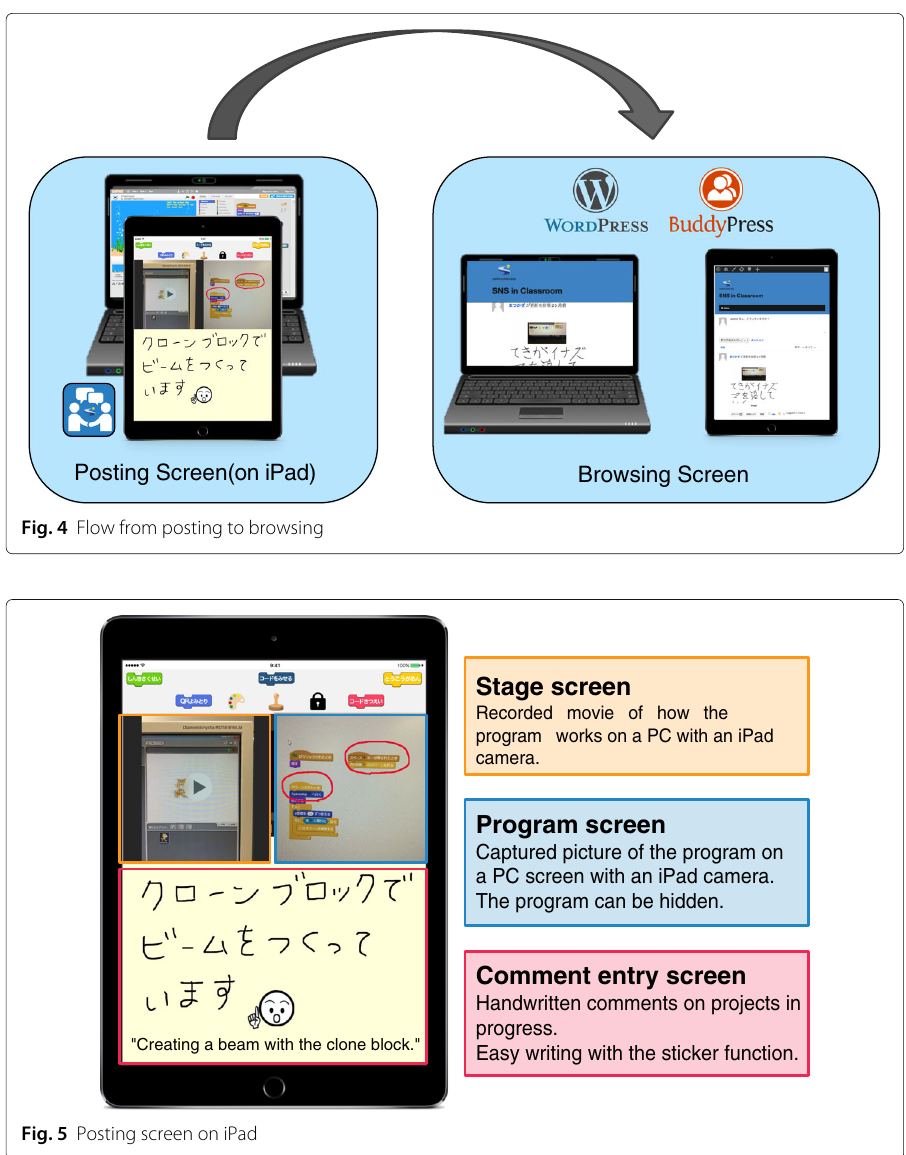
Fig. 5 Posting screen on